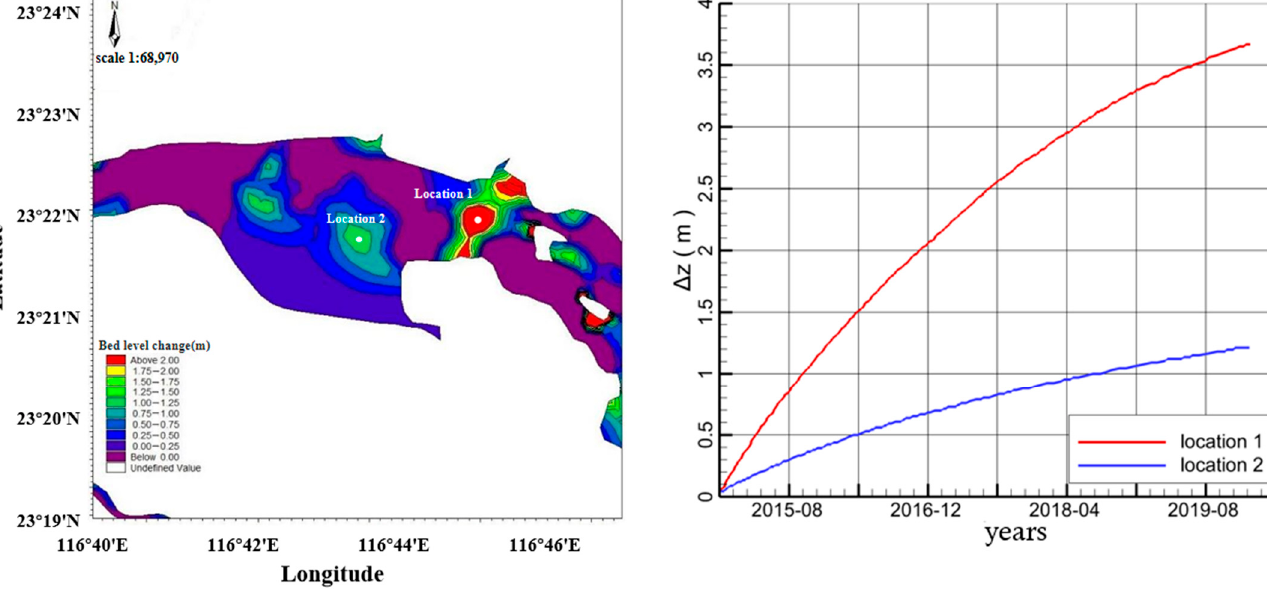
Figure 17. Changes of sedimentation thickness in Shantou Bay in 5 years.